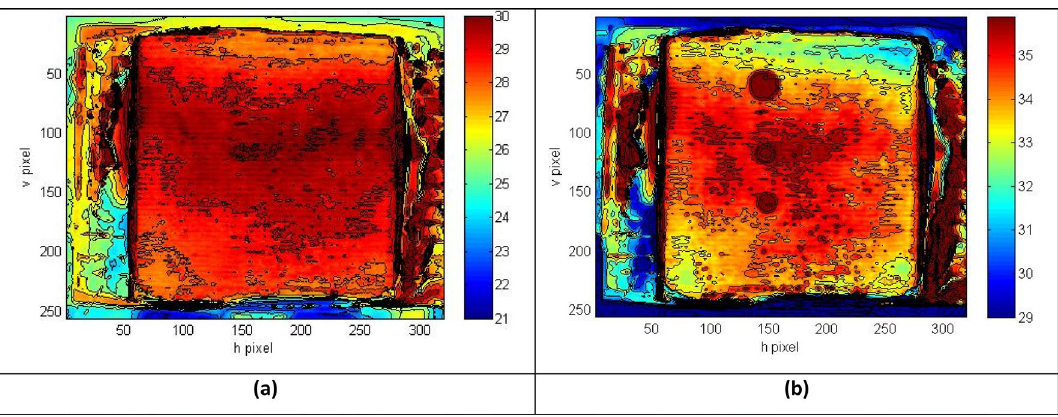
Fig. 4 Maps of isotherms on the panel surface at the beginning of the cooling phase for the traditional thermography, using heating times of 3 s ( a ) and 10 s ( b )